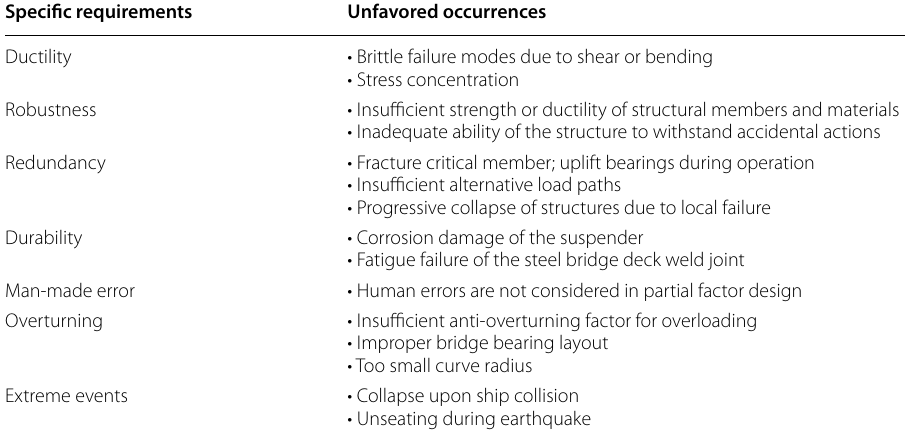
Table 1 Specific requirements for resilience design Specific